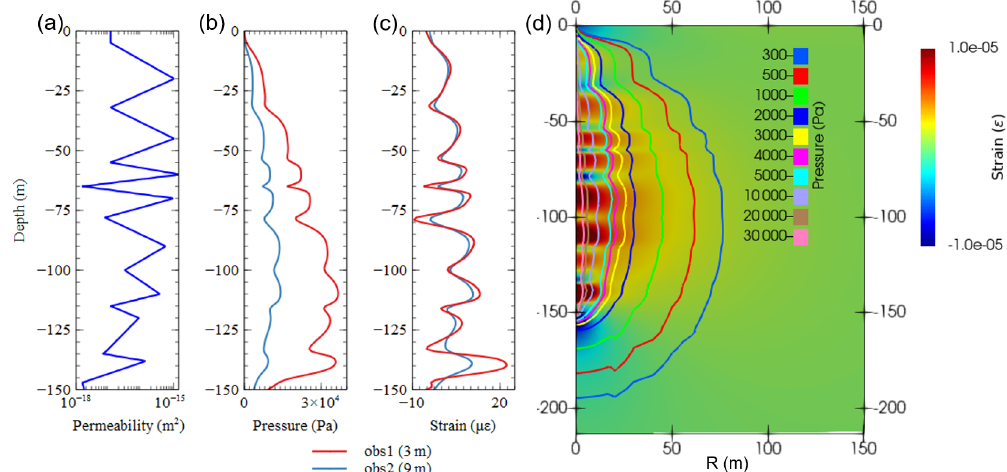
Figure 8. Assumed permeability structure (a) ; profiles of the modeled pore pressure (b) and strain (c) changes at the distance of wells obs1 and obs2; and spatial image of strain with contour of pressure changes (d) on day 10.